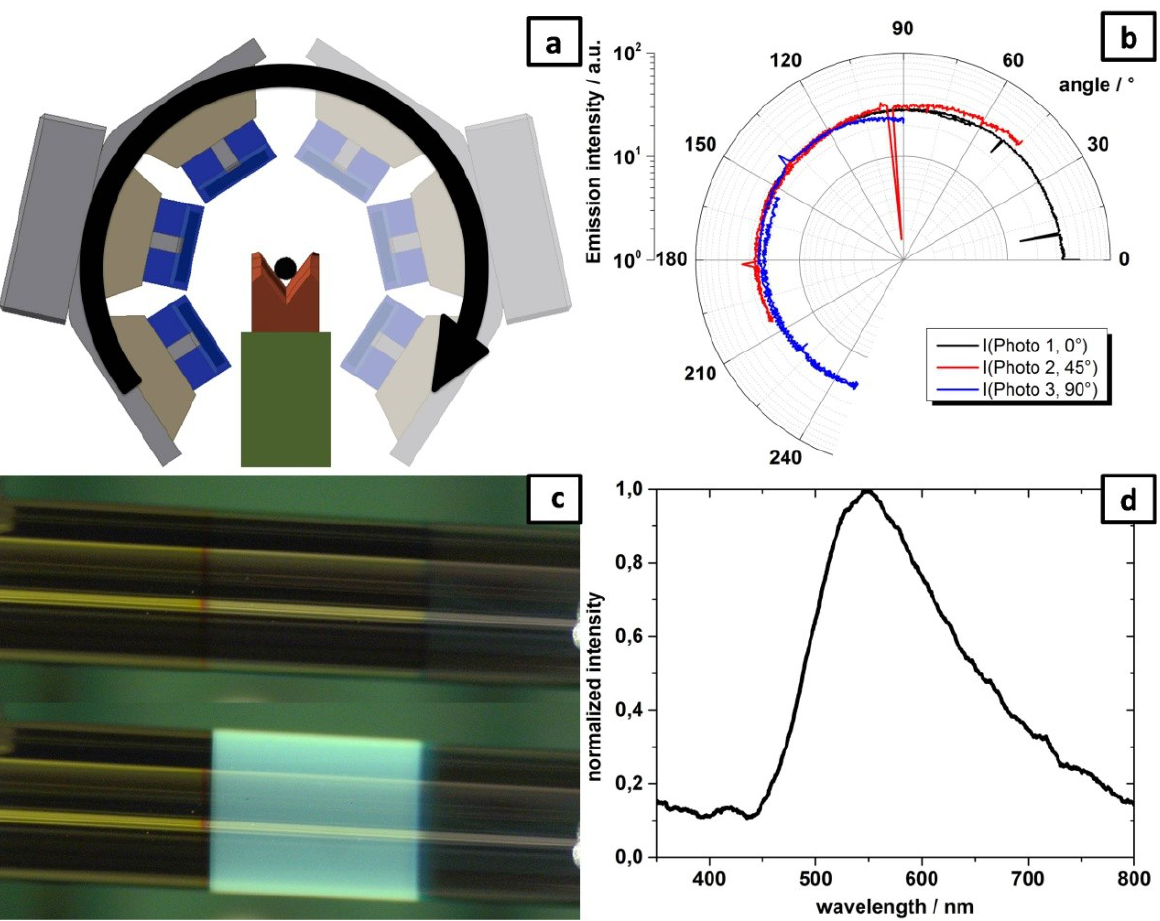
photodiodes (blue) moved on a fixed radius around the OLED; ( b ) Angle dependence of light emission of an OLED processed on a defect-free glass stick using three photodiodes that were rotated around the device; ( c ) Photographs of the 1 mm OLED in the off ( top ) and on state ( bottom ); ( d ) Electroluminescence spectra of the